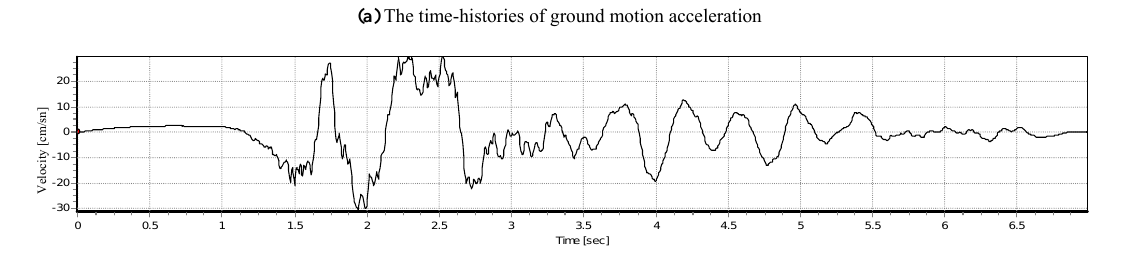
(b) The time-histories of ground motion velocity